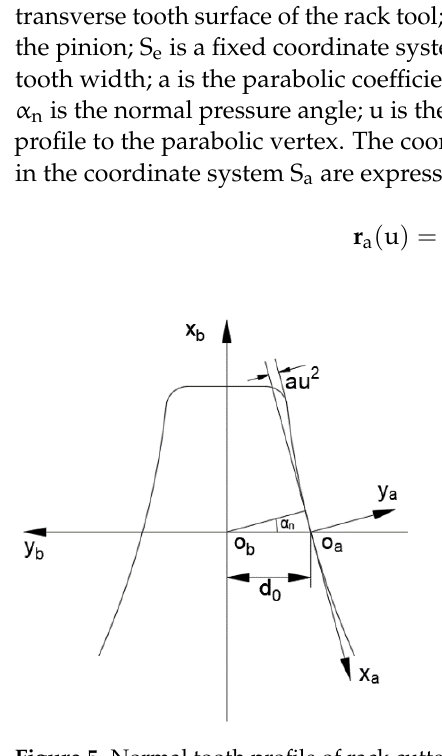
Figure 5. Normal tooth profile of rack cutter.